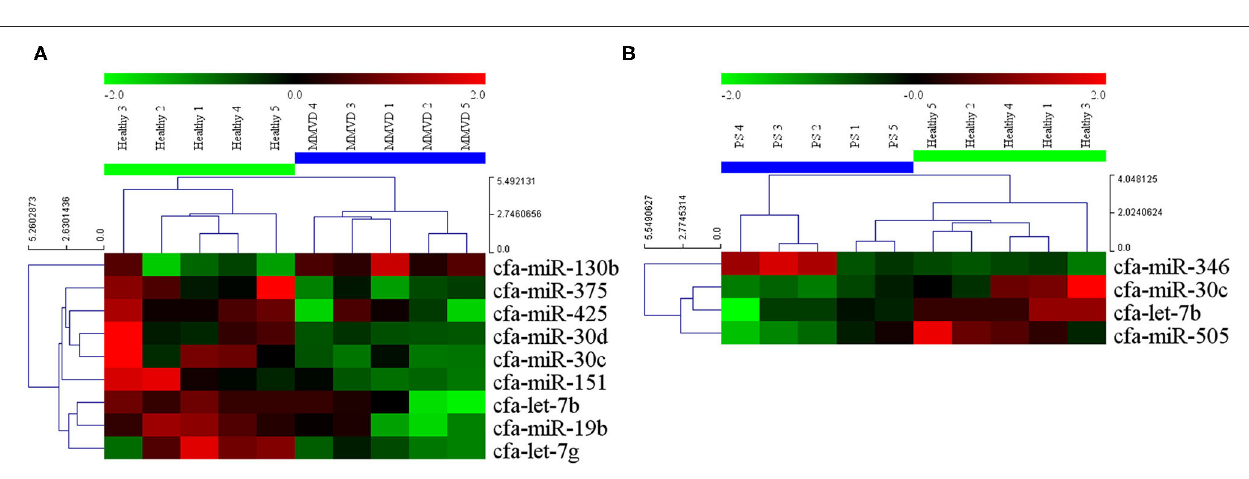
FIGURE 3 | Heat map of significantly altered miRNA microarray expression data from serum samples of dogs with (A) MMVD and (B) PS compared with healthy dogs. Sample species are shown at the top and the miRNA species are shown on the right. Unsupervised hierarchical clustering of expression levels of nine and four ( A and B , respectively) differentially expressed microRNAs using the Euclidian distance measure. The hierarchical clustering completely separated healthy dogs from dogs with heart diseases, showing distinct microRNA patterns among sample types. Red and green colors indicate relatively high and low expressions of microRNA, respectively. miRNA, microRNA; MMVD, myxomatous mitral valve degeneration; PS, pulmonic